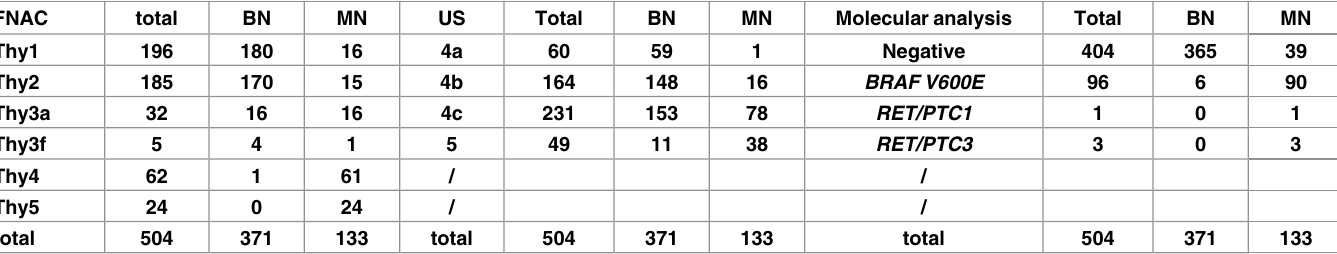
Table 2. Clinicopathological characteristics of 504 thyroid nodules, including US, FNAC and genetic analysis.